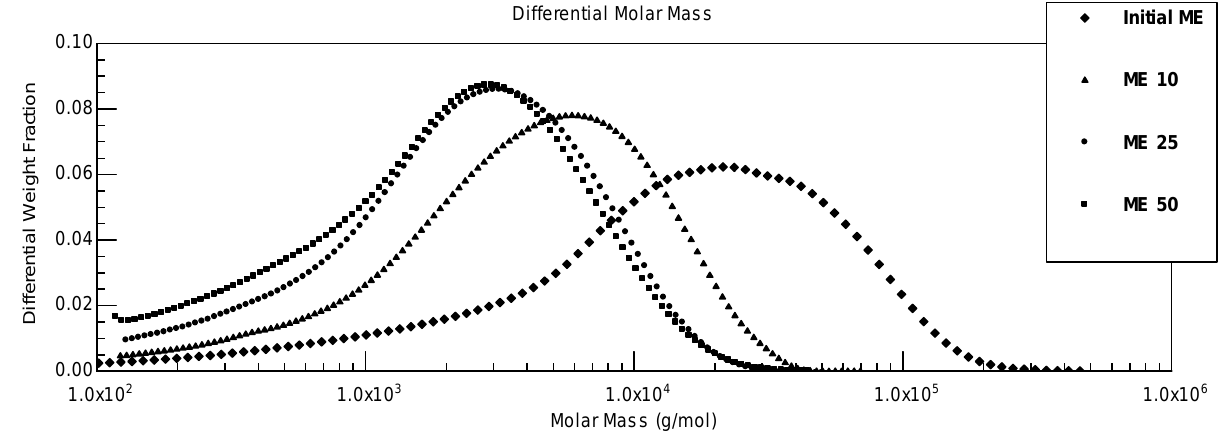
Figure 3. Differential molecular weight distributions for methylcellulose and oxidized methylcelluloses (ME 10, ME 25, ME 50) obtained by steric exclusion chromatography